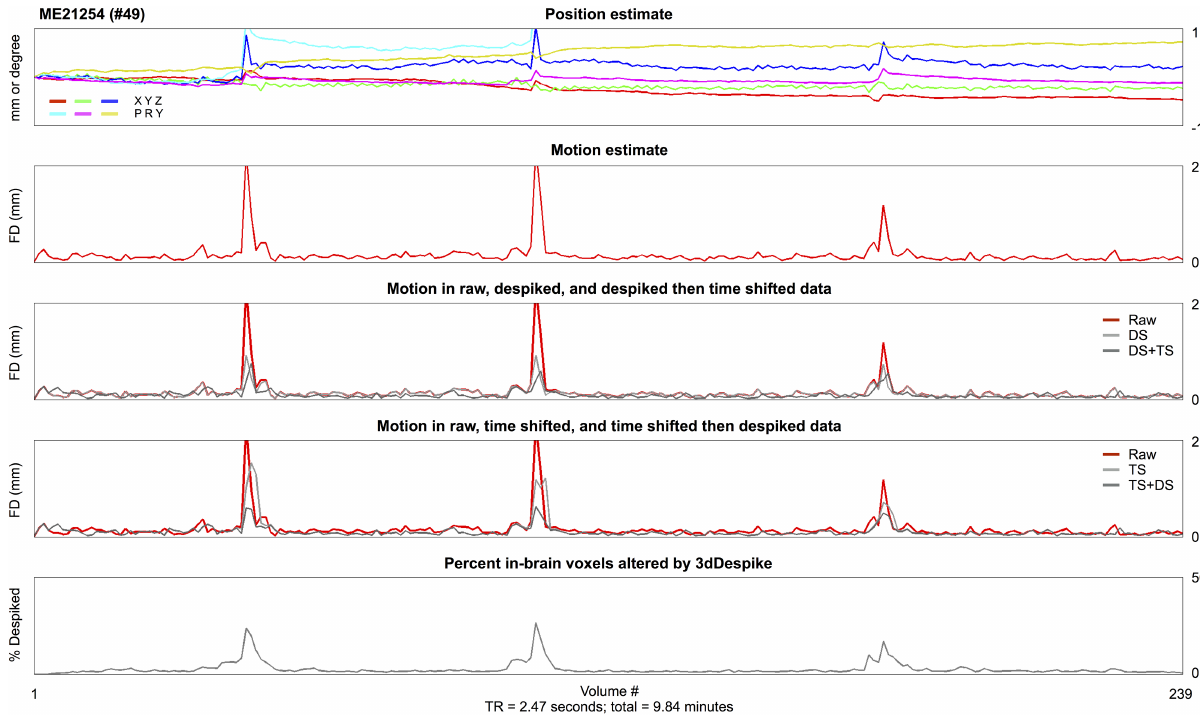
Fig 1. Temporal interpolation reduces motion estimates. All traces are for a single subject of the ME cohort, derived from the second- echo image (TE = 28 ms). At top, positionestimates derivedfrom AFNI’s 3dVolregusing heptic interpolationand an early-run reference volume. The corresponding motion (FD) trace is shown immediately below in red, and below that motion derived in the same data after 4 possibleorderingsof temporal interpolation. At bottom, a trace of the fraction of the brain despikedby 3dDespike (as it operatedon raw data to producethe DS data). See S1 Fig for more parameter spaces in the same data (e.g., different TEs, reference volumes, software packagesused to estimate motion, etc.). See S2 Fig for the same effects after using other software packagesto perform temporal